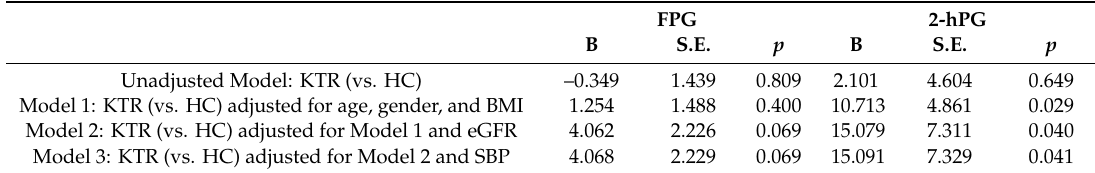
Table 4. Correlation between fasting plasma glucose and 2 h plasma glucose with presence of kidney transplantation in adjusted linear regression analysis. FPG 2-hPG B S.E. p B S.E.